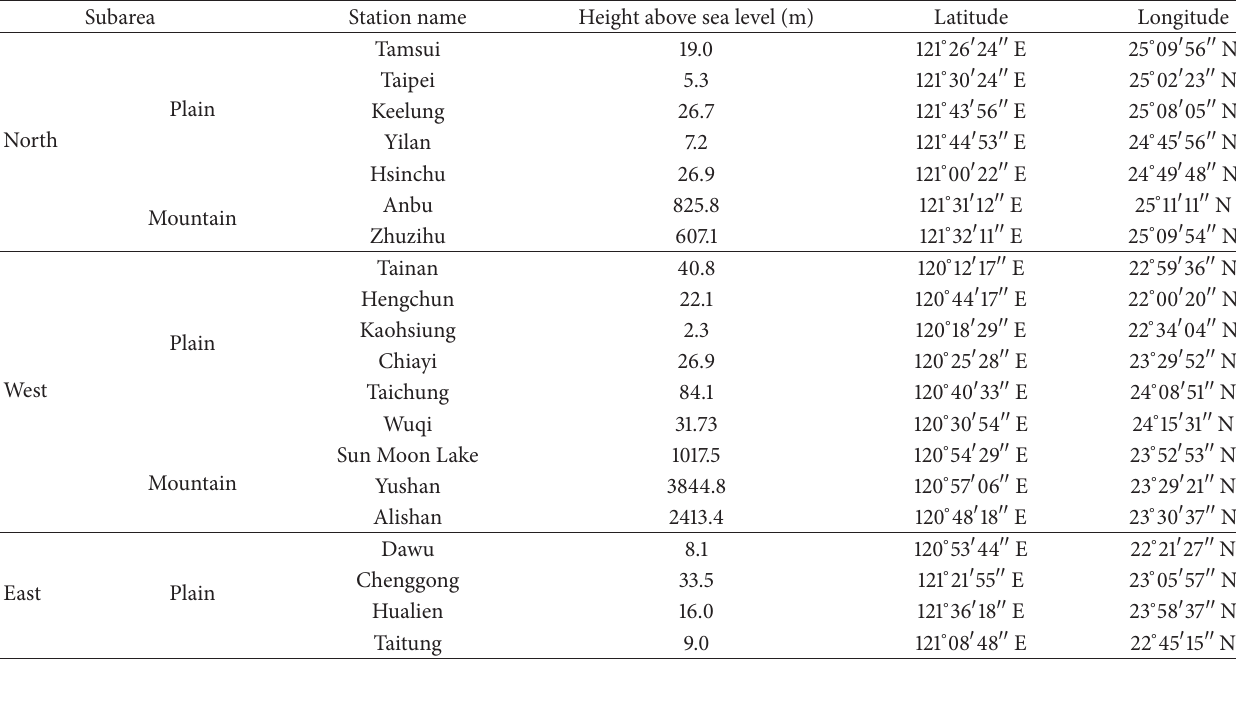
Table 1: Information of rain stations in this study.